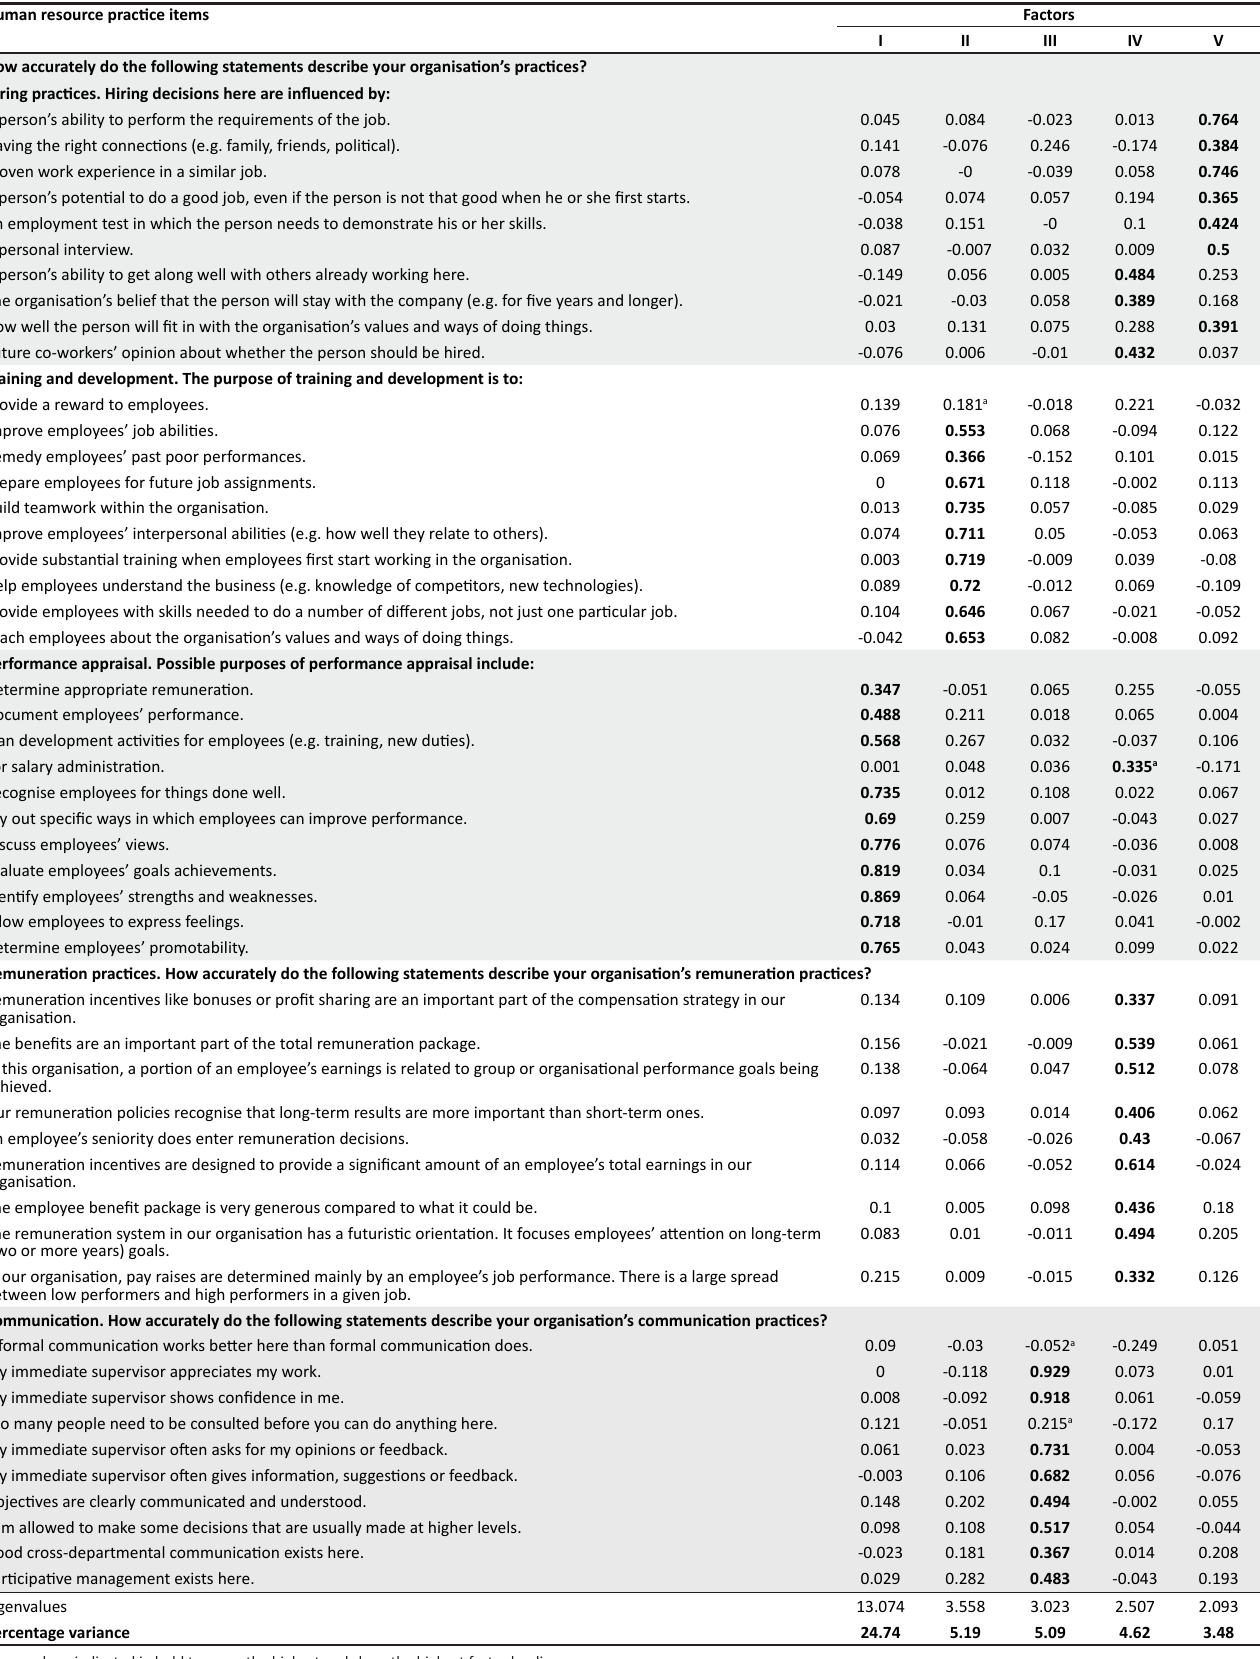
TABLE 9: Patterns in the rotated factor loadings for the Human Resource Practices Scale. Human resource practice